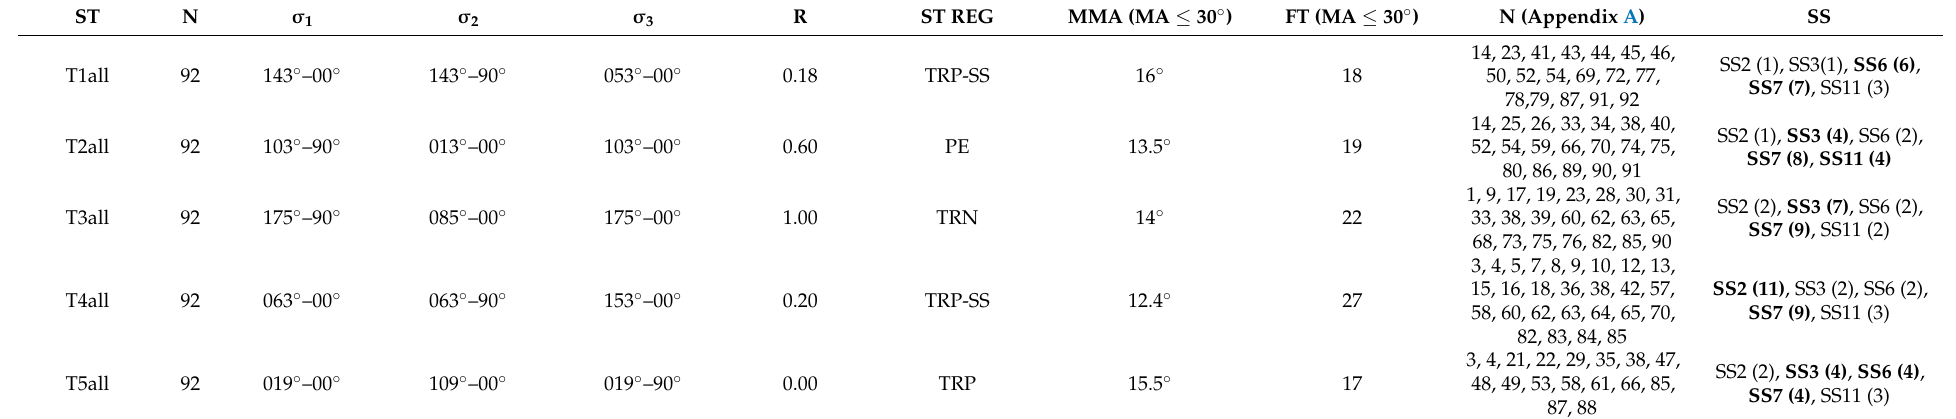
Table 4. The activated fault-slip data under the bulk enhanced Andersonian stress tensors with MA ≤ 30 ◦